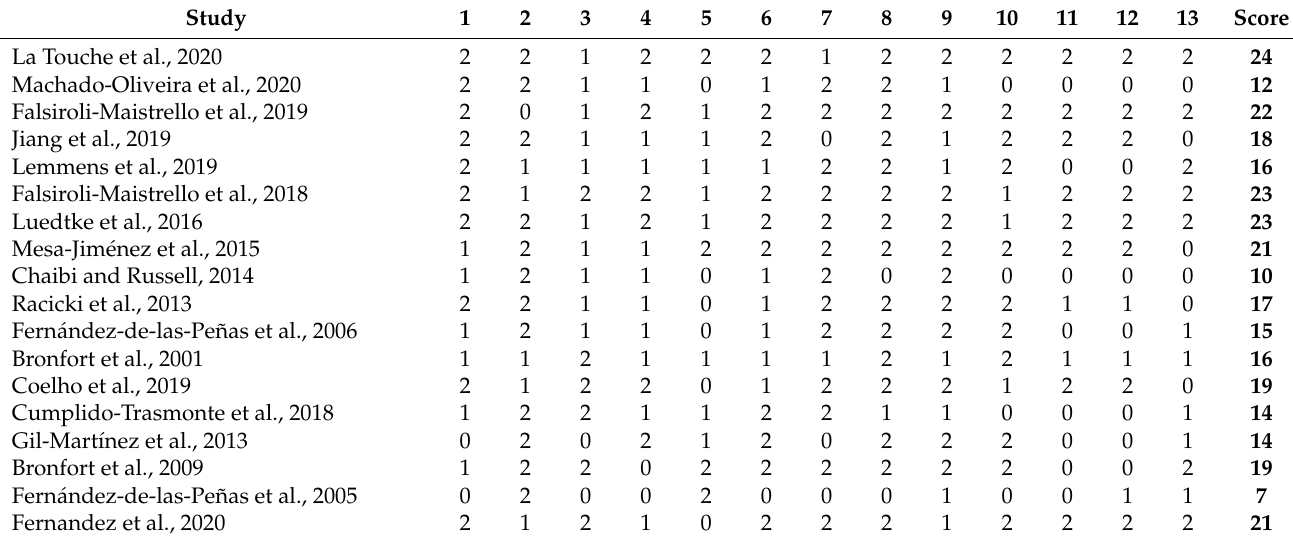
Table 3. Quality assessment